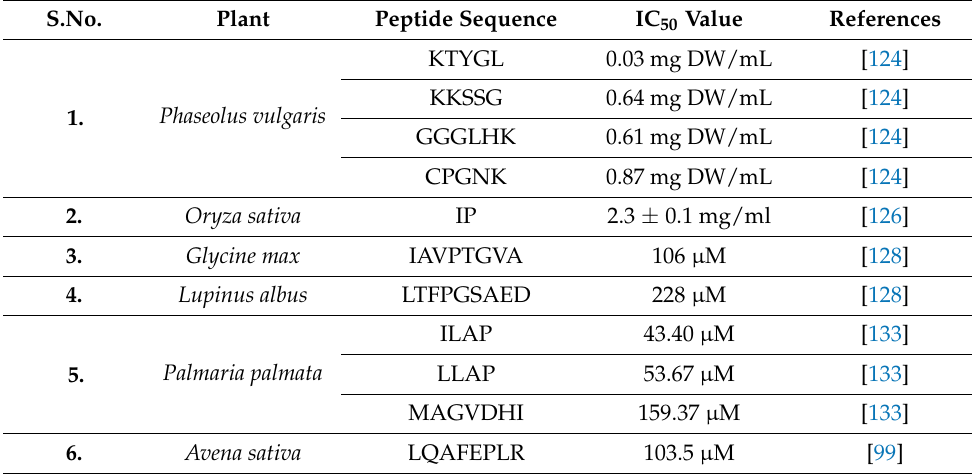
Table 4. Bioactive peptides with DPP-4 inhibition and their corresponding IC 50 values. S.No. Plant Peptide Sequence IC 50